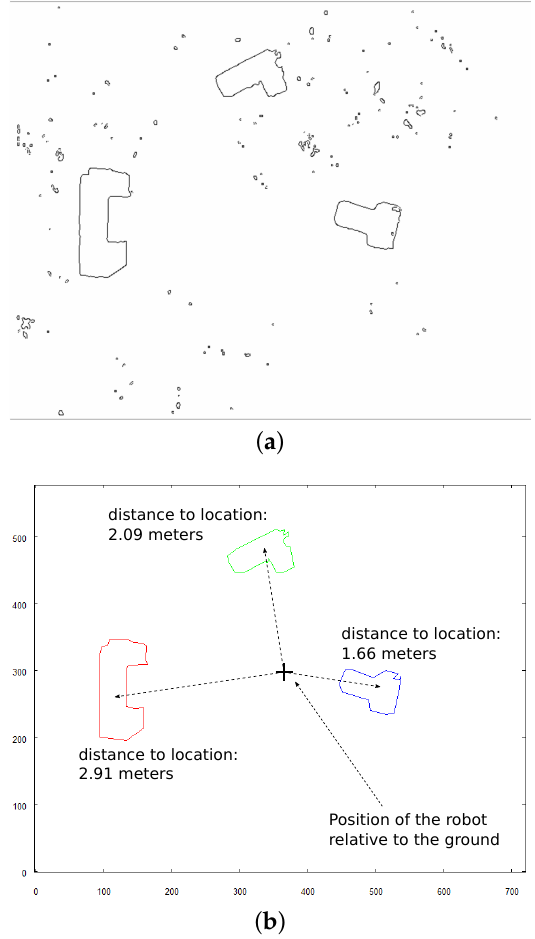
Figure 22. Further steps of processing of overall scene’s image. ( a ) result of applying Canny Edge Detector; ( b ) vectorized image with calculated distance to target positions for robot to take detailed images of each